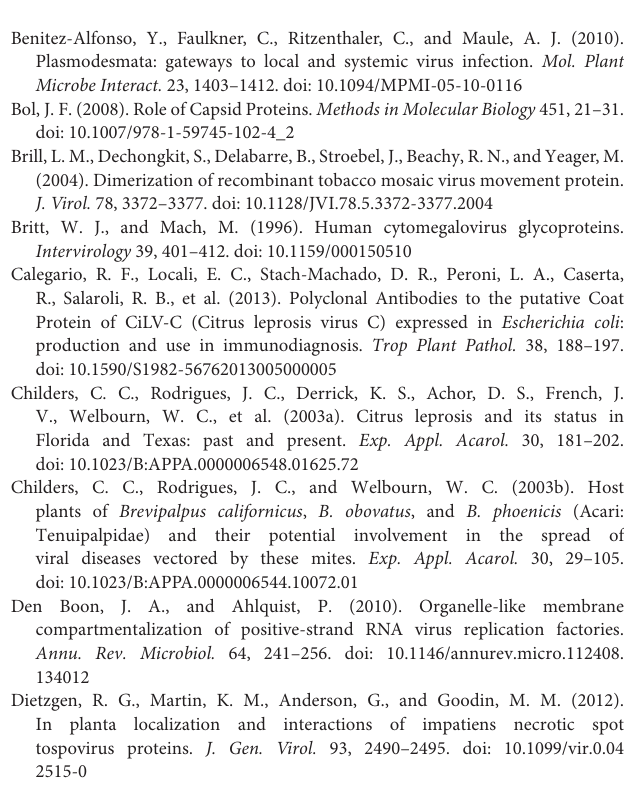
Figure S4 | Hydrophobic prediction analyses of the CiLV-C proteins. (A) Transmembrane region and Coiled coil analyses of the p29, p15, p61, MP, and p24 proteins using different computational tools. For p29, p15, and MP TMDs were not identified, whereas for p61 it was predicted one or three or five TMDs, and for p24, four TMDs. Coiled coil structures were only predicted for p29 and p24. (B) Hydrophobic regions (HR) were predicted for p29, p15, MP, and p24. A schematic representation of the proteins highlighting the HRs can be found at the top of each picture (in orange). Hydrophobic profile of the proteins is shown in the graphics generated with MPEx tool. The red lines show the mean values using a window of 19 residues and the yellow line indicates the predicted HRs. Values of 1 G of the TMD are indicated for p24. (C) Coiled coil domains of the p29 and p24 proteins were identified by PCOILS server. The green, blue and purple lines represent the results obtained with a window 14, 21, and 28, respectively. Table S1 | Nuclear localization/exportation signals, signal peptide, and N-glycosylation analyses of the CiLV-C proteins using computational tools. Movie S1 | Citrus leprosis virus C p29:eGFP punctate and inclusion bodies trafficking throughout the cytoplasm in N. benthamiana cells. Arrows mark the position of the p29 structure at each time point. Punctate sturtures shows a fast mobility (red arrows), while inclusion shows a slower movement (white arrows; (avi). at each time point trafficking along the cortical ER. Blue, green and yellow arrows mark individuals p29:eGFP punctate bodies, which merge into a larger aggregate (inclusions) represented by red arrow (avi). of continuous movement of the MP structures